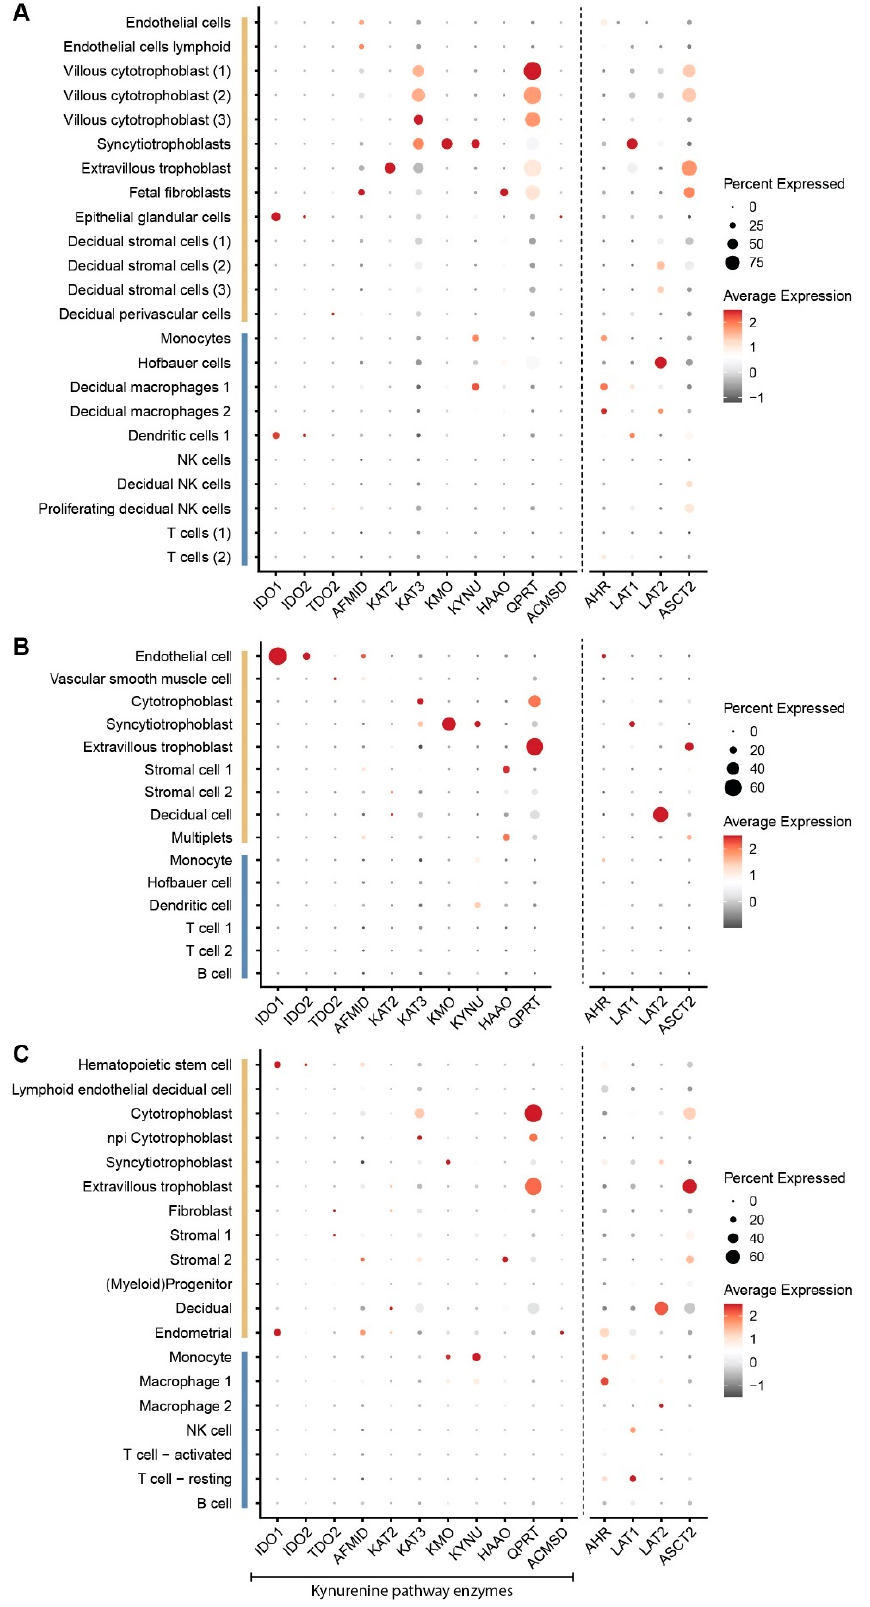
Figure 3. Cell type specific mRNA expression of kynurenine pathway enzymes, receptor, and transporters in placental tissue. Data were obtained using the single cell RNA sequencing data from first trimester placentas by Vento-Tormo et al. [49] ( A ), and term placentas by Pique-Regi et al. [50] ( B